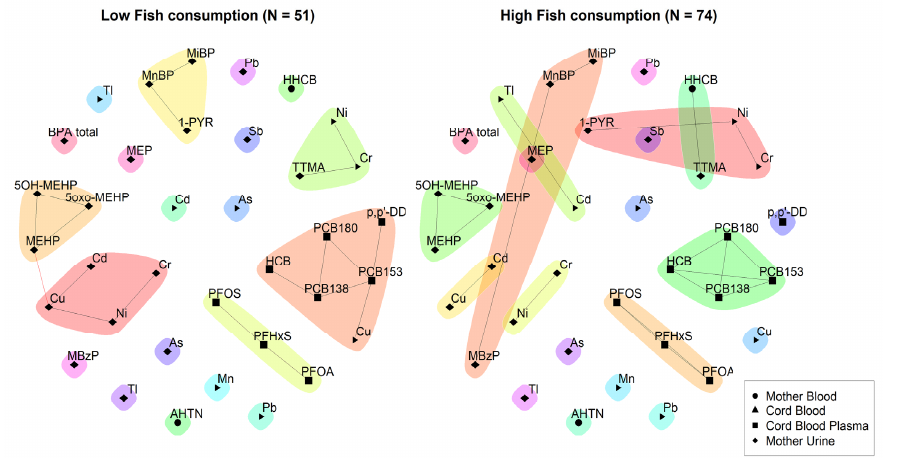
Figure 8. 3xG: unweighted network for participants with a low fish consumption ( left ) and partici- pants with a relatively high fish consumption ( right ). The data were corrected for age and smoking. Urinary markers were standardised for creatinine and lipid soluble blood markers were standard- ised for lipids. Low fish consumption is defined as consumption of fish less than 1–3 times per week and high fish consumption is defined as fish consumption of at least 1–3 times per week. Black lines indicate dependency between nodes (biomarkers) within a community; red lines indicate depend- ency between nodes in different communities.